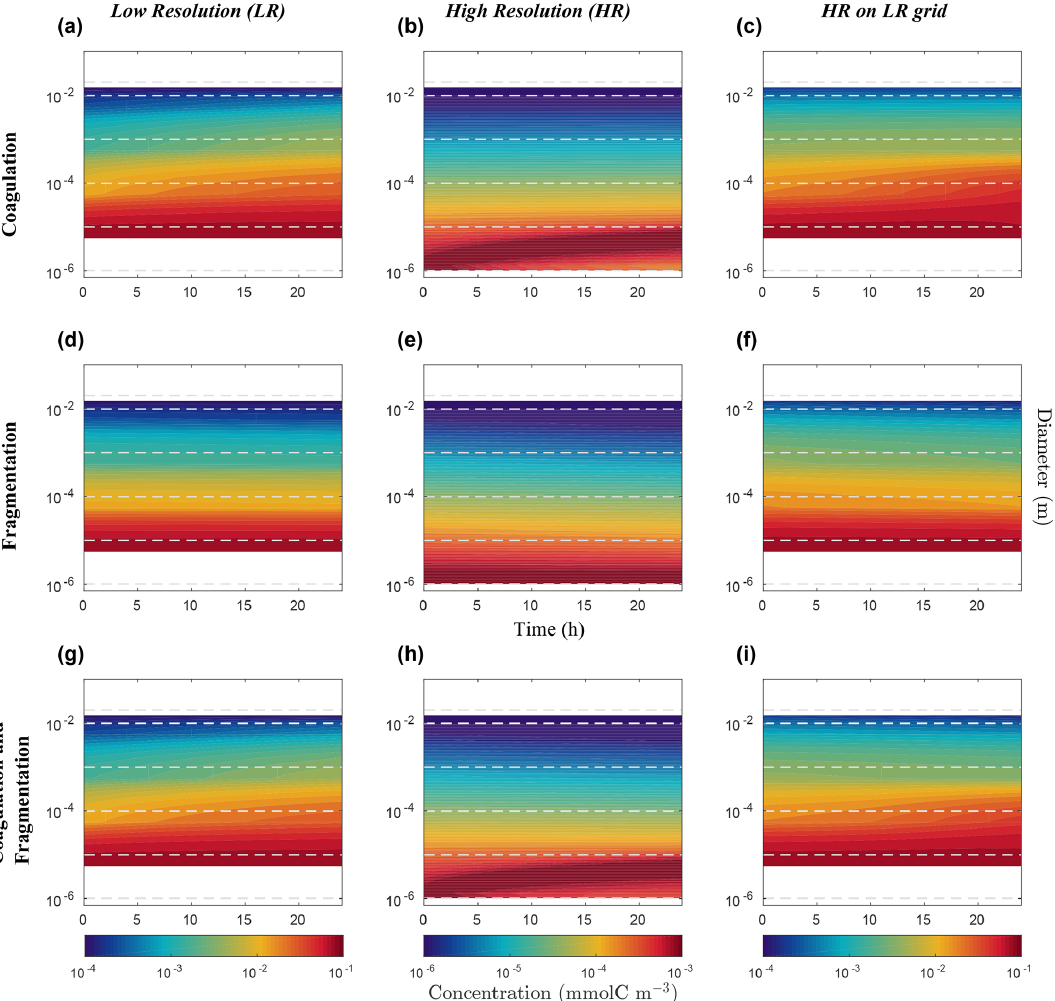
Figure 9. Hovmöller plots of carbon concentration as a function of particle diameter over a 24h period for the nonlinearly discretized configuration (E2) with the application of the function which attempt to reduce the dependency to the resolution of our model (Eq. 27). Simulations for coagulation and fragmentation considered separately (on top and middle lines, respectively) and combined (on bottom line), and for LR (left column) and HR (middle column), are shown. For further details, refer to the legend of Fig.